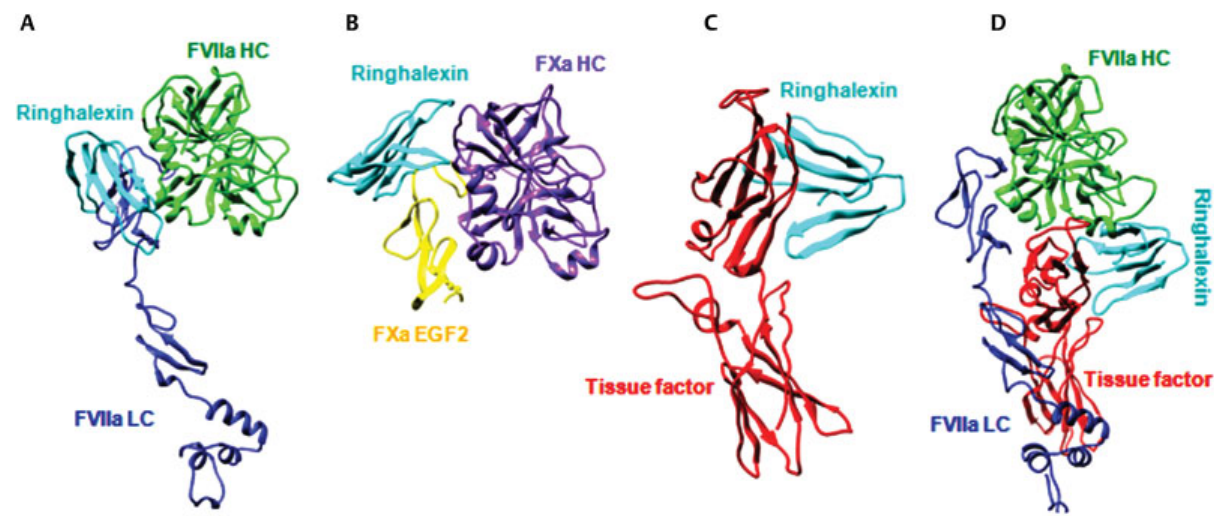
Fig. 4 Molecular docking of ringhalexin with coagulation factors of the extrinsic tenase complex. Interactions of ringhalexin with ( A ) FVIIa, ( B ) FX, ( C ) TF, and ( D ) TF-FVIIa. HC, heavy chain; LC, light chain.